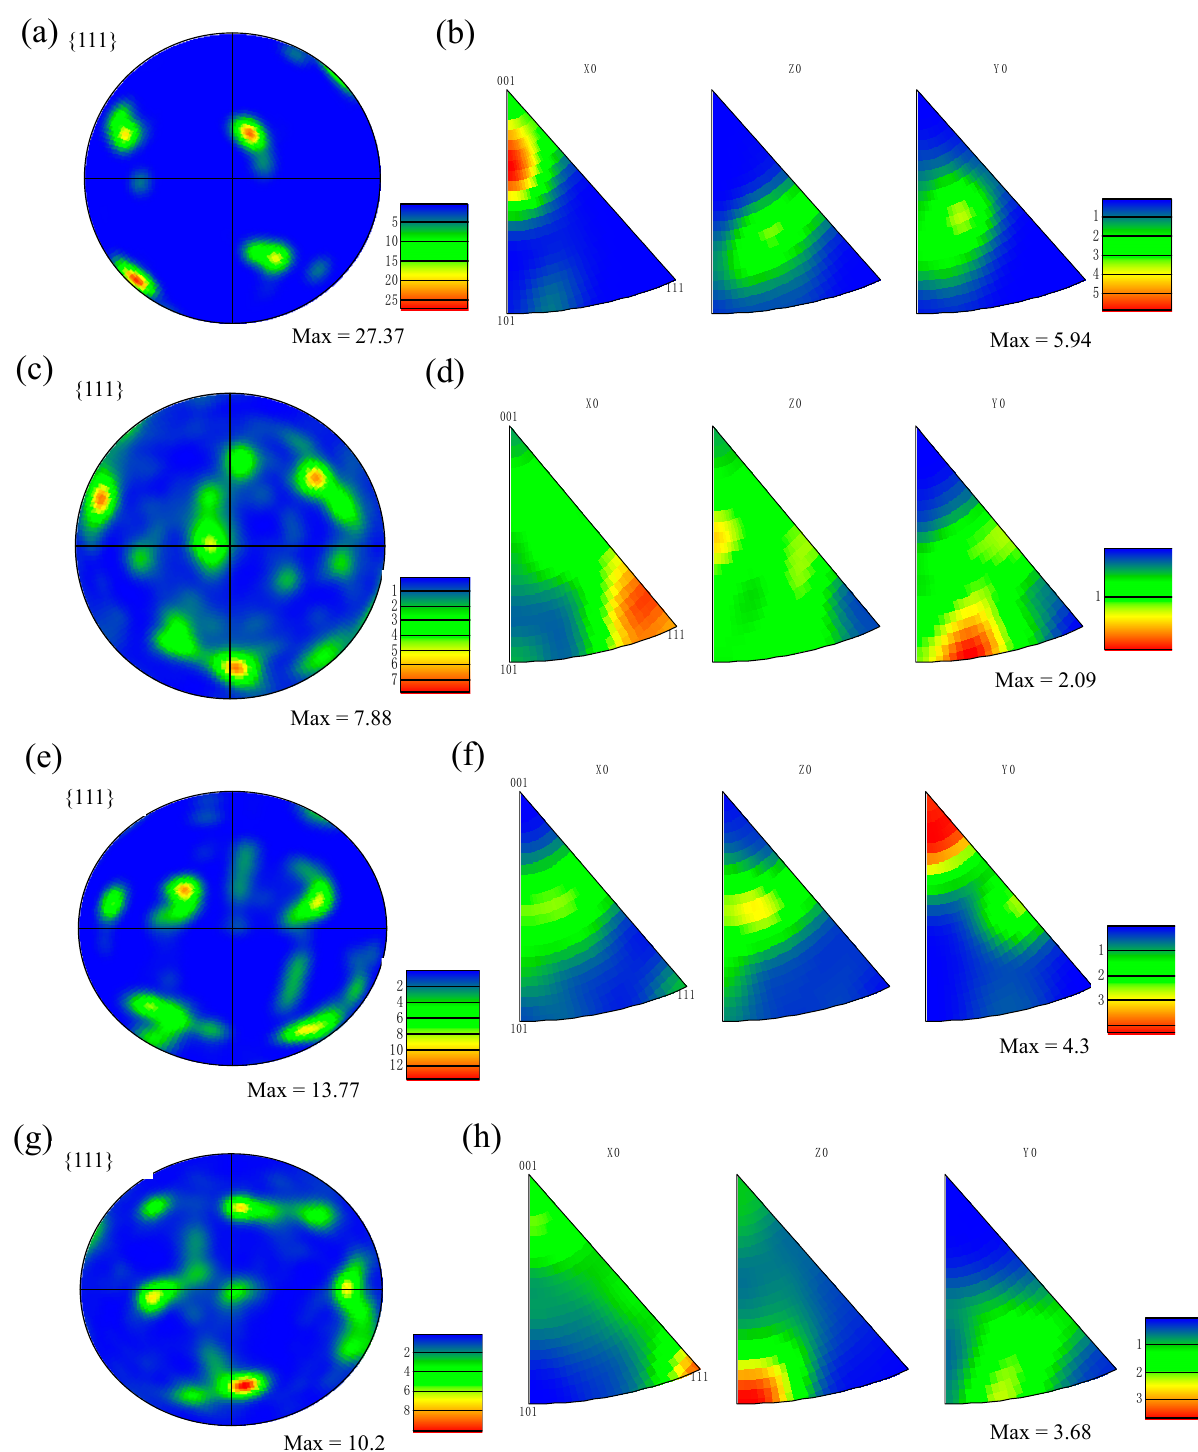
Figure 8. Pole figure IPF maps of annealed 1561 aluminum alloys at different deformation stages. ( a , b ) the H1 plate; ( c , d ) the H2 plate; ( e,f ) the N1 plate; ( g , h ) the N2 plate. For further analysis, orientation distribution functions sections (ODFs) of ϕ = 0, 15 ◦ , 30 ◦ , 45 ◦ , 60 ◦ , 75 ◦ and 90 ◦ of the four samples were plotted in Figure 9. As seen, the main texture components of plates are (123) <634> S, (110) <100> Goss, (110) <112 > Brass and Fiber texture. However, the cube texture intensity of the N1 plate is more remarkable than that of the N2 plate. At the same time, some weak copper textures can be found in Figure